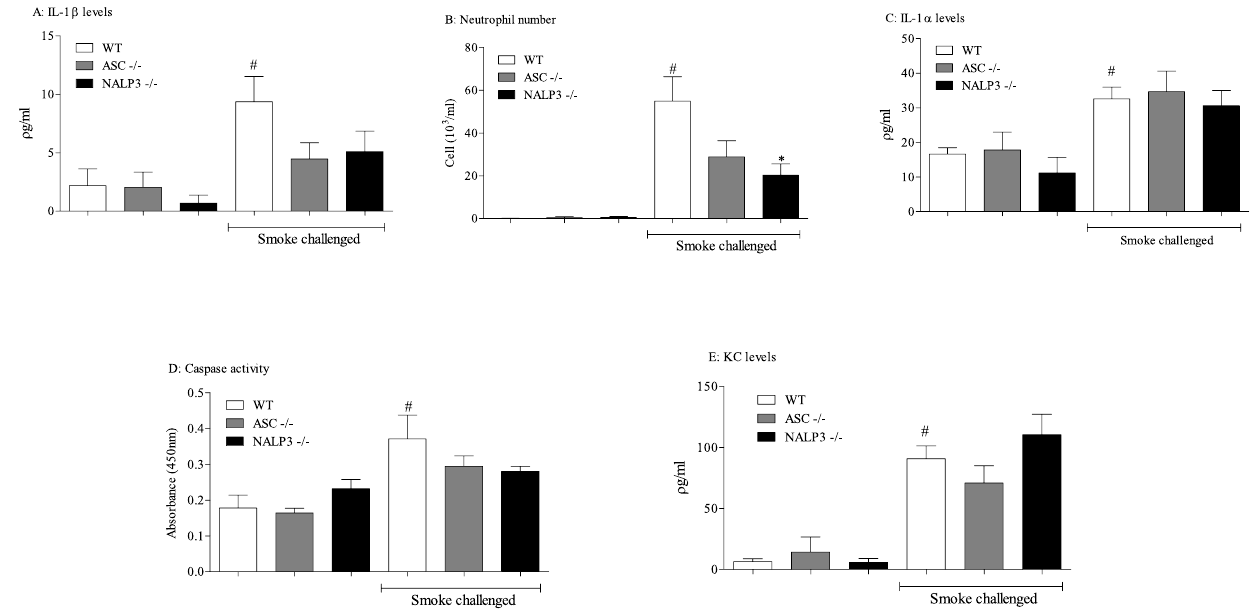
Figure 2. Role of the NALP3 inflammasome in CS-driven model. NALP3 or ASC -/- mice were exposed to CS or room air (control) twice daily for 3 consecutive days alongside wild-type controls. BALF and lung tissue was collected 24 hours after the last exposure for measurement of IL-1 b (A), neutrophil (B), IL-1 a (C), caspase 1 activity (D) and KC (E) levels. Data are represented as mean 6 S.E.M. for n=8 animals in each group. Statistical significance was determined using Mann-Whitney U test. # =P , 0.05, denoting a significant difference between the smoke exposed and air exposed wild-type groups; * =P , 0.05, denoting a significant difference between the smoke exposed knock-outs and wild-types (one-way ANOVA).